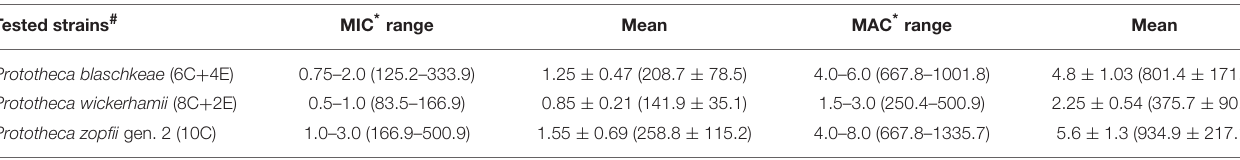
TABLE 2 | Biological activity of 3BP against Prototheca spp.